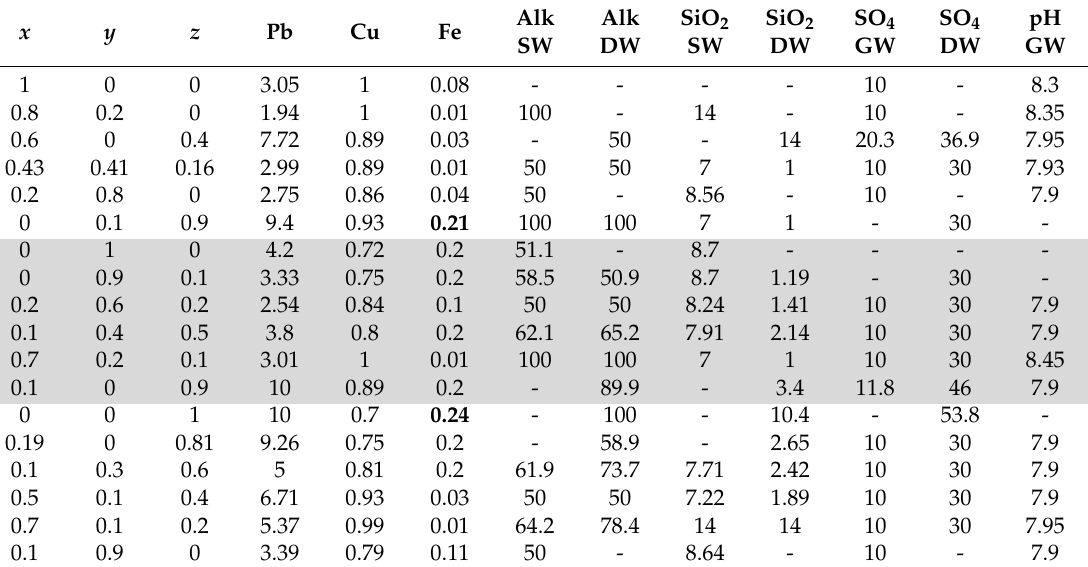
Table 4. Results of MSWBO with w 1 = 1, w 2 = 1 and w 3 =